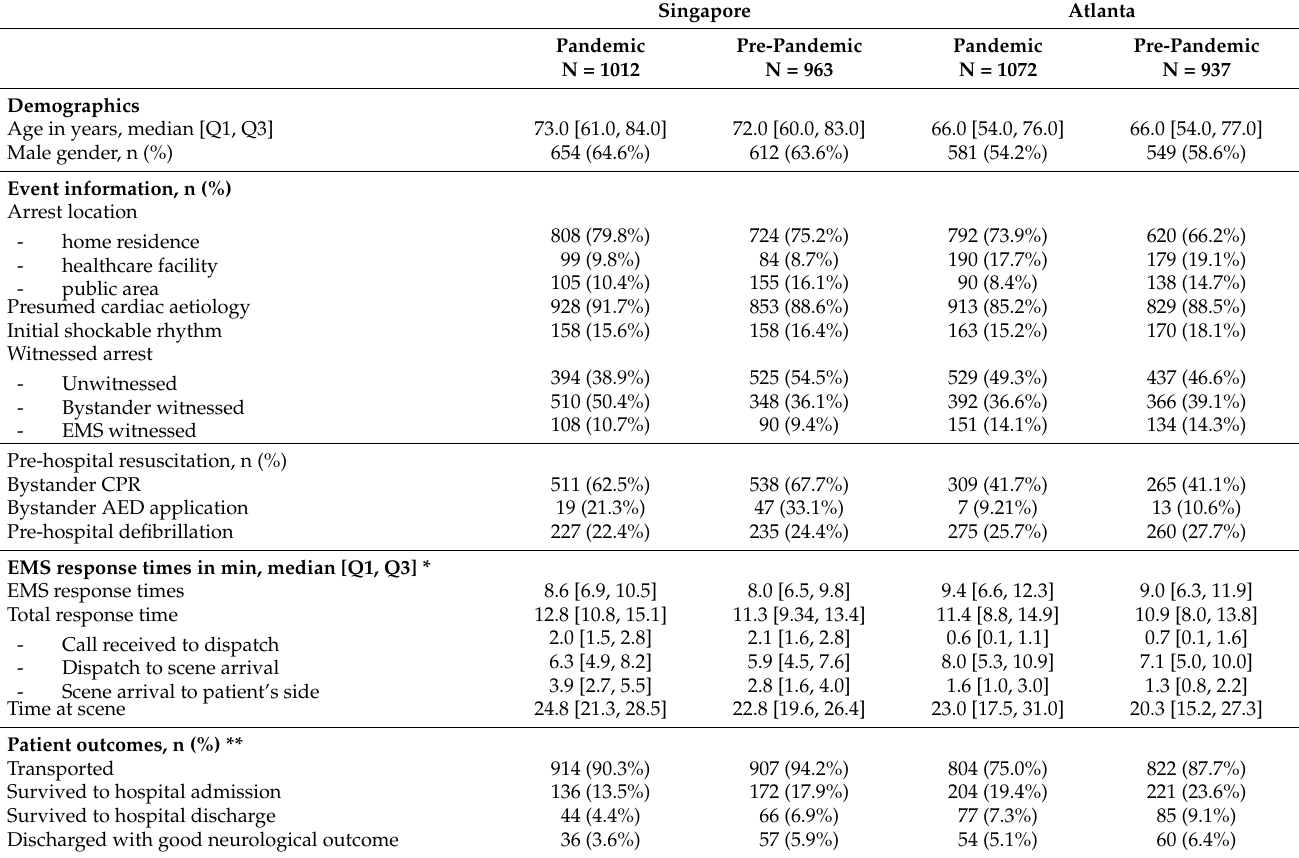
Table 3. Characteristics of EMS-treated OHCA and outcomes, by city and period.